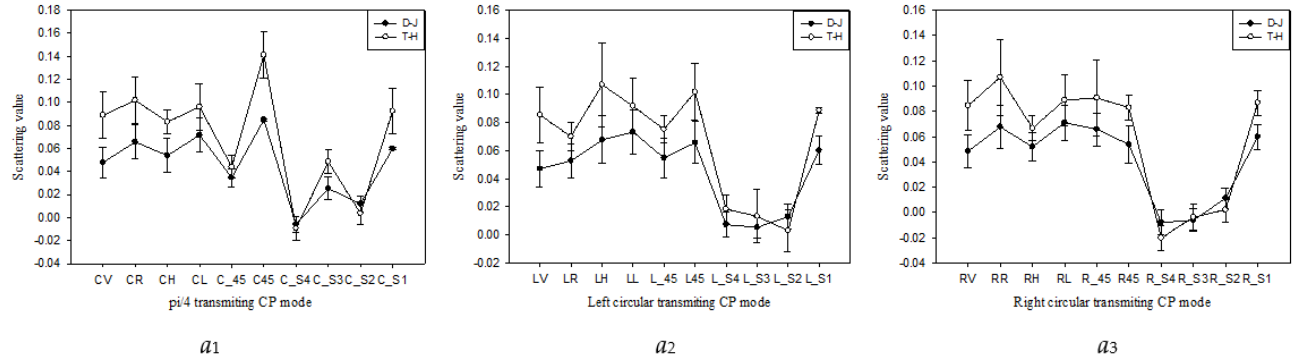
Figure 4. The CP parameters line diagram of the two types of rice under three transmitting modes (( a 1 ): π /4 transmitting mode; ( a 2 ): left circular transmitting; ( a 3 ): right circular transmitting) on 12 June 2015 (0612 period).